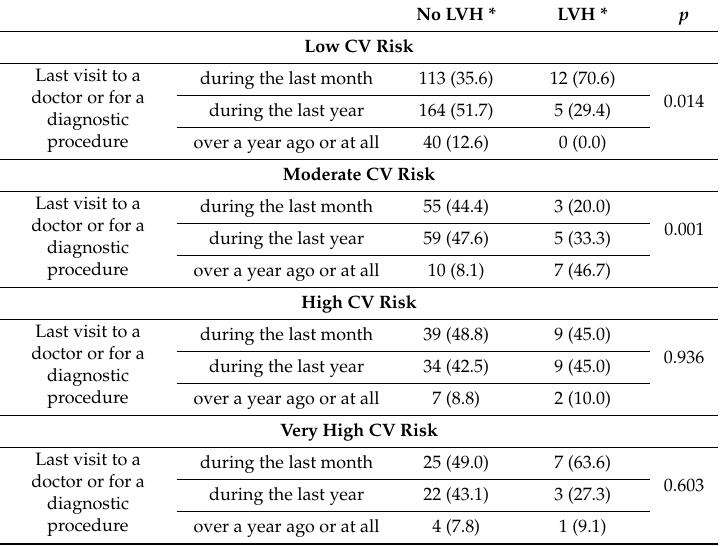
Table 9. Last visit to a doctor or for a diagnostic procedure in patients by CV risk category with respect to the presence of LVH in ECHO